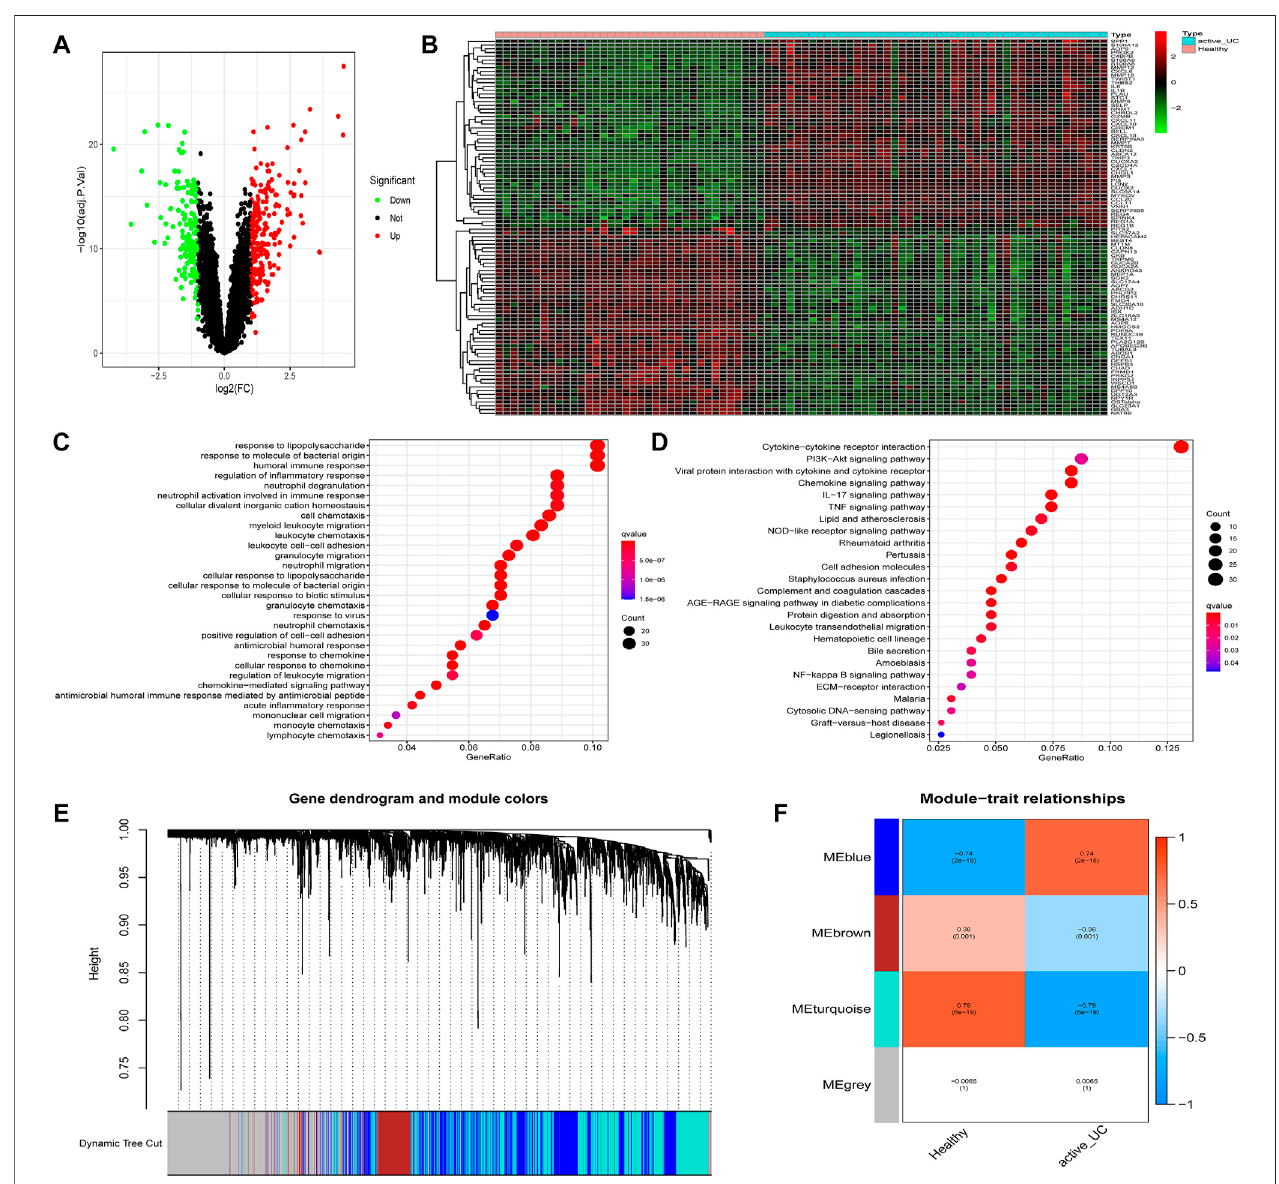
FIGURE 3 | Identi fi cation of DEGs and modules associated with active UC. (A) Volcano map of DEGs in the intestinal mucosa between active UC patients and healthy control. Red represents up-regulated genes, green represents down-regulated genes, and black represents no signi fi cant difference genes. (B) The expression pro fi les of top 50 DEGs between active UC patients and healthy controls. The red togreen colors represent the change from high to lowexpression. (C) GO enrichment analysis of DEGs. (D) KEGG pathway enrichment analysis of DEGs. (E) Module clustering dendrogram based on a dissimilarity measure (1-TOM). (F) Heatmap of the correlation between module eigengenes and active UC. DEG, differentially expressed genes. UC, ulcerative colitis. GO, the Gene Ontology. KEGG, the Kyoto Encyclopedia of Genes and Genomes analyses. TOM: topological overlap matrix.